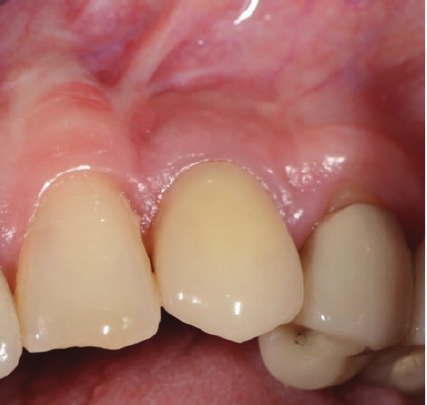
Figure 6: Seven-year follow-up clinical picture of a maxillary left canine case treated according to the protocol and grafted with Fortoss